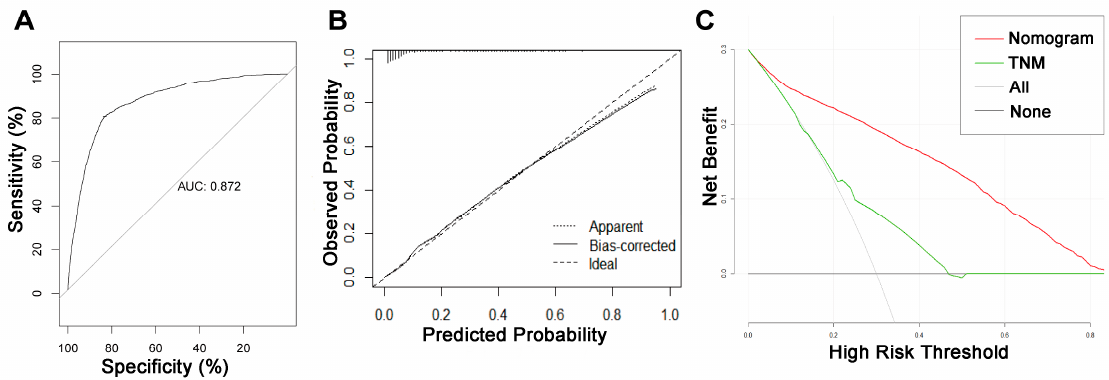
Figure 2. ROC curve, calibration curve, and decision curve analysis of the nomogram model for the risk of liver metastasis in pancreatic cancer. ( A ) AUC values were used to evaluate the predictive performance of the nomogram. ( B ) Calibration curves of the nomogram model. The diagonal 45-degree line indicates a perfect prediction. ( C ) Comparison of the diagnostic nomograms and TNM staging DCA curves. The net benefit, calculated by adding the true positives minus the false positives, corresponds to the measurement on the Y-axis; the X-axis represents the threshold